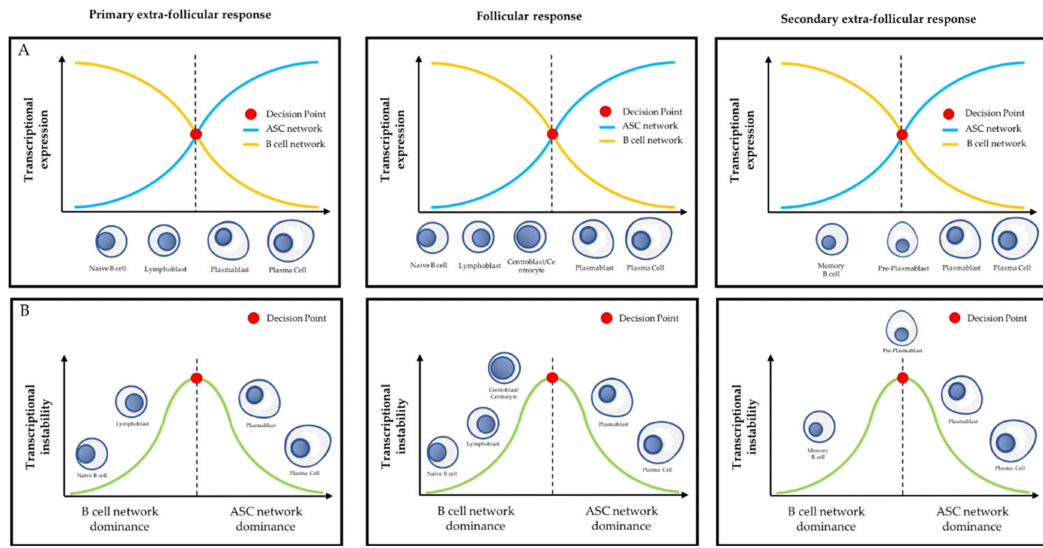
Figure 5. Transcriptional di ff erentiation during PC di ff erentiation. ( A ) Relationship between the antagonistic B cell transcriptional network and the ASC transcriptional network according to the cell di ff erentiation step during the primary extra-follicular response (left), follicular response (middle), and secondary extra-follicular response (right). ( B ) Representation of the stability of the transcriptional network during PC di ff erentiation. According to this model, naïve B cells and memory B cells represent the stable cell type that durably expresses B cell transcriptional network factors, and PC represents the stable cell type that durably expresses ASC transcriptional network factors. Other cell types (e.g., lymphoblasts, centroblasts, centrocytes, pre-PB, and PB) are transient and transcriptionally unstable, being are the site of active antagonism between the B cell and ASC transcriptional networks. The decision point represents the cell fate choice point where the transcriptional switch between the B cell network and the ASC network occurs, irreversibly inducing the activation of the ASC program and the extinction of the B cell